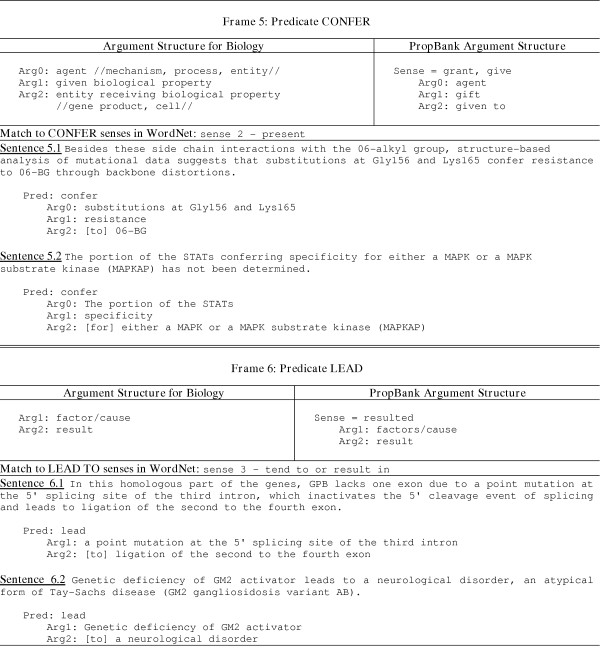
Examples of predicate-argument structures for group C Predicate confer and lead are assigned to group C – same sense, same structure, so their structures constructed in PASBio are as same as in PropBank [22, 23] as shown in Frame 5 and Frame 6, respectively.